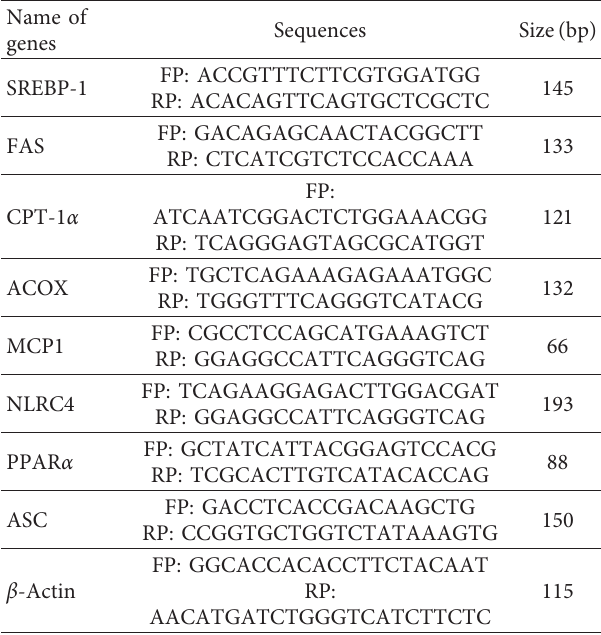
Table 2: Primer sequences